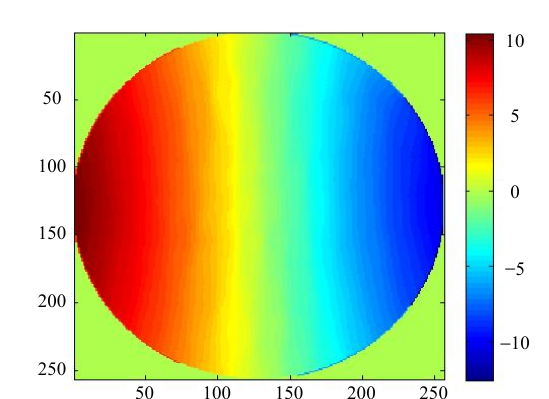
Fig. 10 RMS of the restoration phase with the conventional 9-frame phase shifting algorithm.